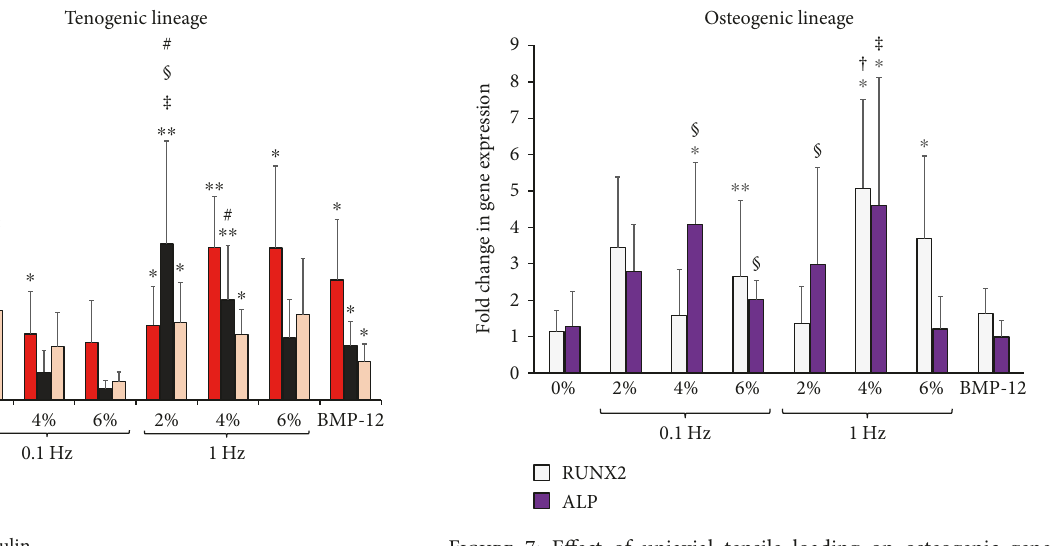
Figure 7: E ff ect of uniaxial tensile loading on osteogenic gene expression of ASCs within 3D collagen sca ff olds. Gene expression pro fi les of ASCs encapsulated within collagen sca ff olds subjected to BMP-12 treatment or uniaxial loading at 0% (unloaded), 2%, 4%, and 6% strains at 0.1Hz and 1 Hz loading frequencies. The graphs depict fold changes in osteogenic markers: RUNX2 and ALP. ∗ indicates signi fi cant fold increase with respect to the 0% samples. ∗ indicates p < 0 05 , ∗∗ denotes p < 0 01 . † represents a signi fi cant di ff erence between 2% and 4% groups while ‡ is the statistical di ff erence with respect to 6% group, both with a 95% con fi dence interval. # represents a signi fi cant di ff erence between 0.1 Hz and 1Hz groups at the same magnitude of strain with p < 0 05 . § depicts signi fi cant di ff erence with respect to unloaded samples chemically stimulated with BMP-12 with p < 0 05 . Samples stimulated with 4% strain at 1Hz showed increased levels of both osteogenic